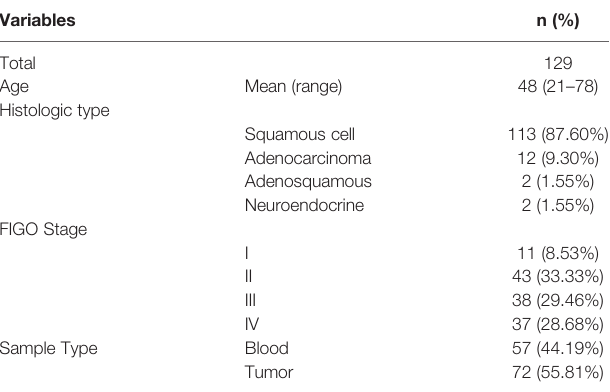
TABLE 1 | Characteristics of 129 patients with cervical cancer.